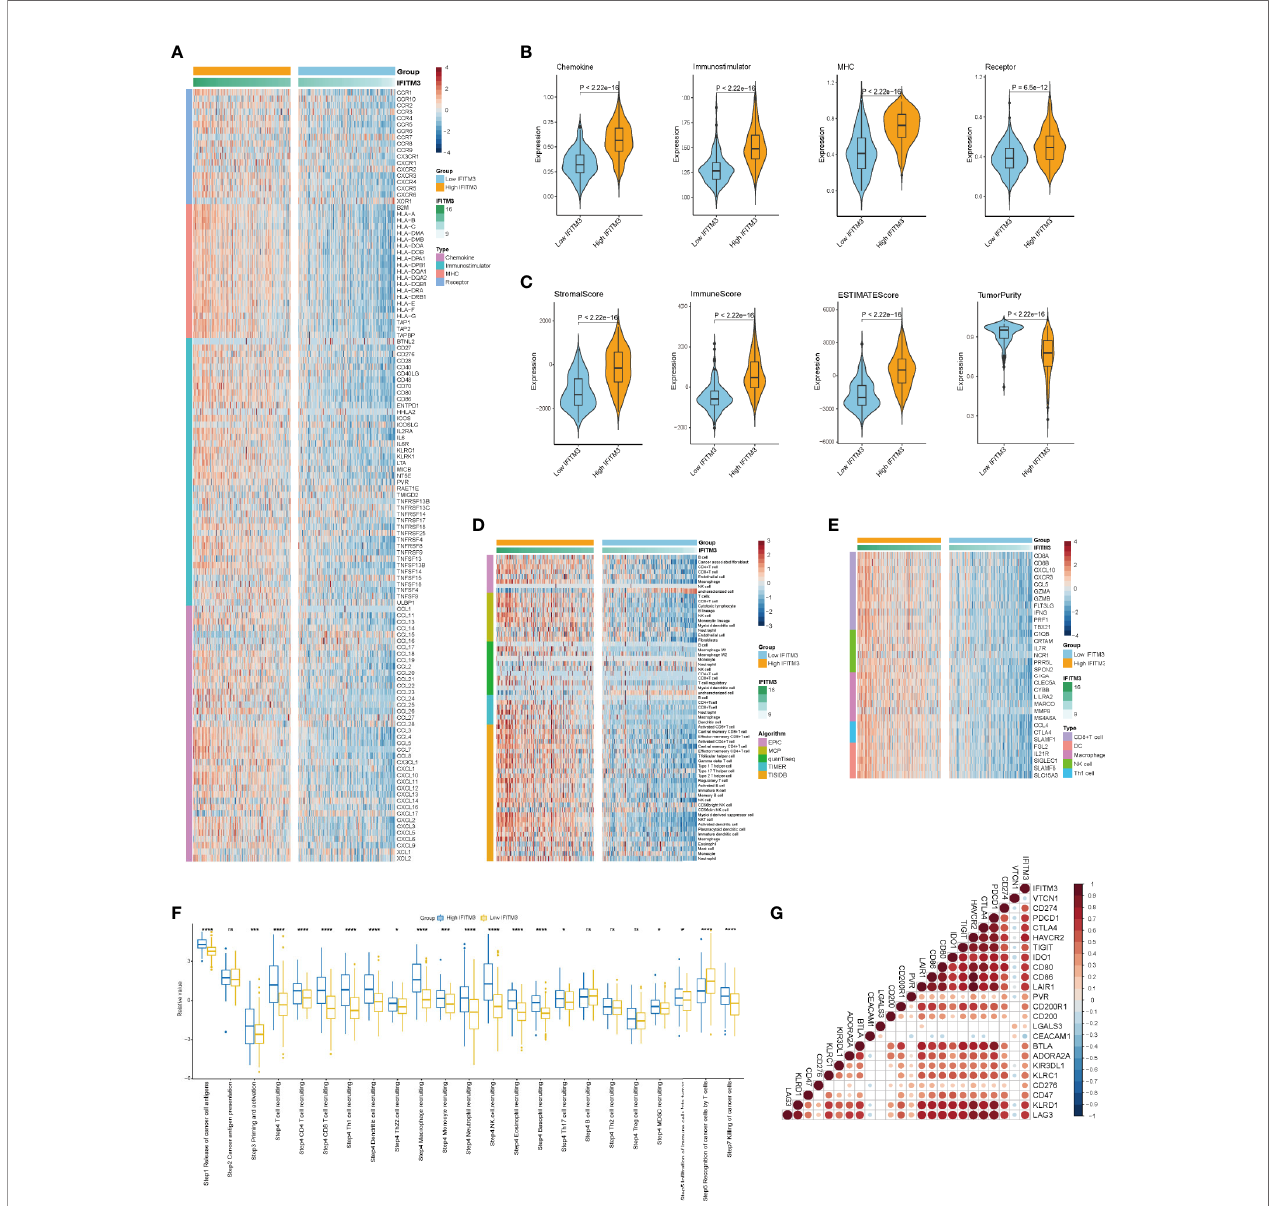
FIGURE 2 | IFITM3 shapes an in fl amed TME in BLCA. (A, B) Expression levels of 122 immunomodulators (chemokines, immunostimulators, MHC, and receptors) in the high- and low-IFITM3 groups in BLCA. (C) Distribution of tumor purity, ESTIMATE score, immune score, and stromal score calculated using the ESTIMATE algorithm in the high- and low-IFITM3 groups. (D) The levels of TIICs calculated using fi ve algorithms (TIMER, EPIC, MCP-counter, quanTIseq, and TISIDB) in the high- and low-IFITM3 groups. (E) Expression levels of the gene markers of the common TIICs in the high- and low-IFITM3 groups. (F) The activities of the various steps of the cancer immunity cycle calculated by ssGSEA algorithm in the high- and low-IFITM3 groups. (G) Correlations between IFITM3 and common inhibitory immune checkpoints. The color and the values indicate the Pearson correlation coef fi cient. *p-value ≤ 0.05, **p-value ≤ 0.01, ***p-value ≤ 0.001, and ****p-value ≤ 0.0001. NS, no statistical signi fi